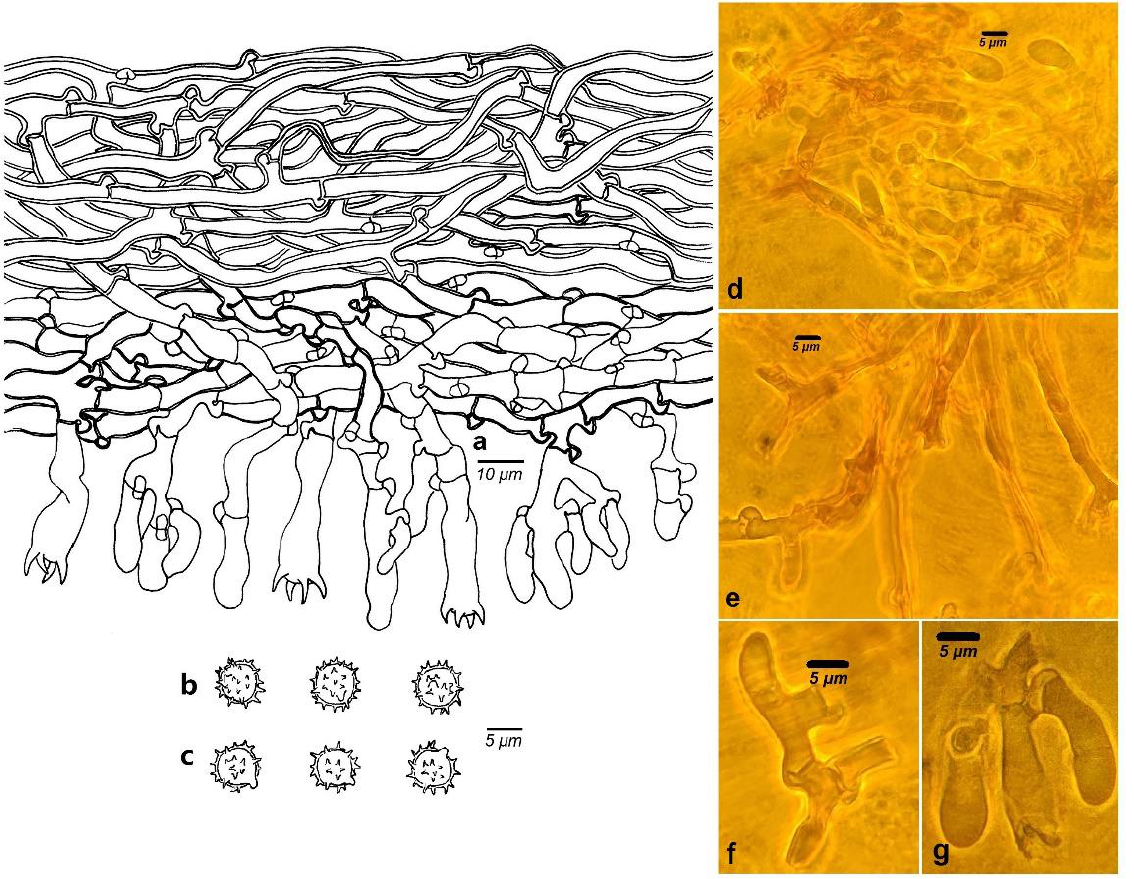
Figure 6. Microscopic structures of Tomentella schrenkiana (drawn from Yuan 14262). ( a ) A section through basidiocarp. ( b ) Basidiospores in frontal view. ( c ) Basidiospores in lateral view. ( d ) Optical microscope images of subhymenial hyphae and basidia. ( e ) Optical microscope images of subicular hyphae. ( f , g ) Optical microscope images of basidia.